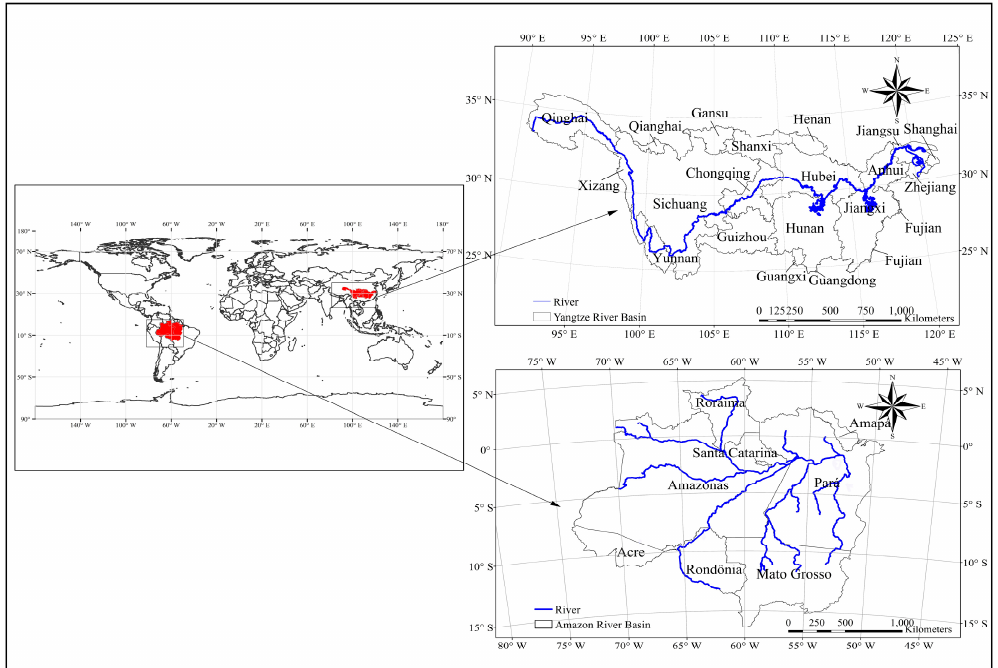
Figure 1. Study Area.